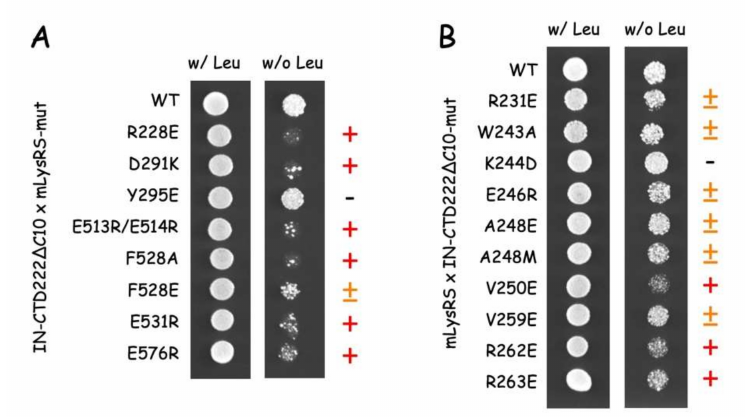
Figure 8. Two-hybrid analysis of mLysRS:IN-CTD interaction. The CTD of HIV-1 integrase (IN-CTD222 ∆ C10) was expressed fused to LexA in pEG202, and mLysRS was expressed fused to the B42 transcription activator under the control of a galactose-inducible promoter in pJG4-5. ( A ) Wild-type IN-CTD222 ∆ C10 was co-expressed with wild-type or mutants of mLysRS. ( B ) Wild-type mLysRS was co-expressed with wild-type or mutants of IN-CTD222 ∆ C10. Yeast cells were grown in a galactose-containing medium in the presence (w / Leu) or in the absence of leucine (w / o Leu). When the two proteins interact, yeast cells are able to grow in a medium lacking leucine. Mutations have either no e ff ect (-), or have a moderate ( ± ) or strong e ff ect ( + ) on yeast growth. Viruses 2020 , 12 , x FOR PEER REVIEW